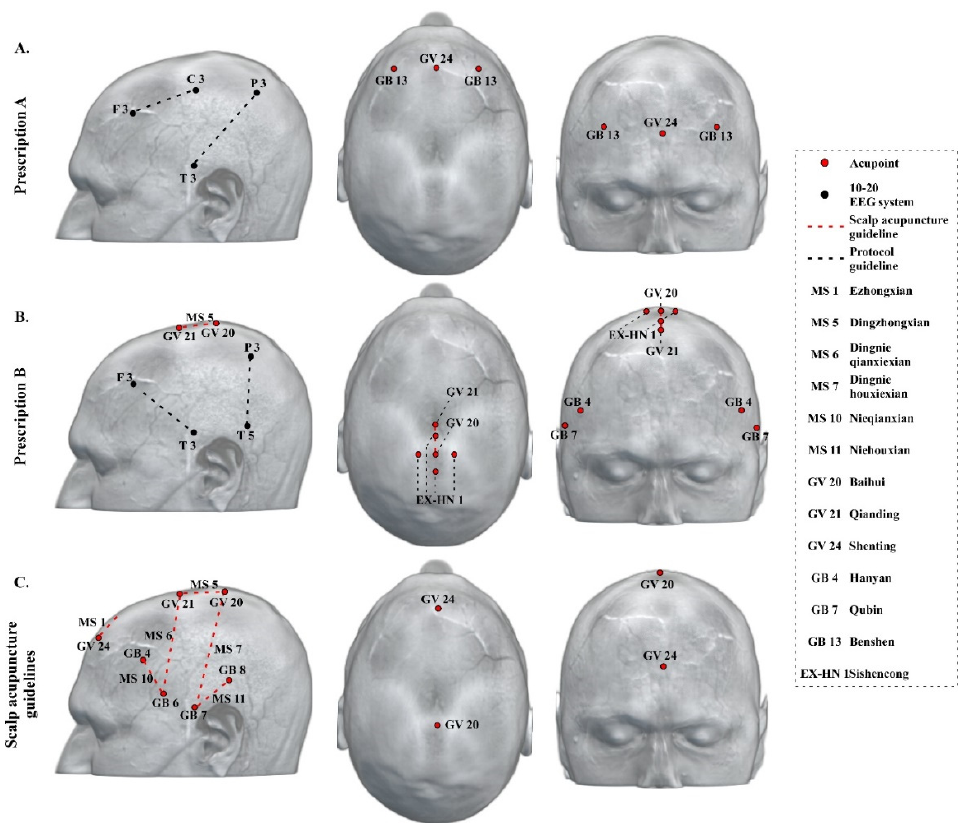
Figure 2. Neuroimaging-based scalp acupuncture prescription for dementia. ( A ) Prescription A, F3 to C3, T3 to P3, Shenting (GV 24), and bilateral Benshen (GB 13). B. Prescription ( B ) F3 to T3, P3 to T5, MS 5, Sishencong (EX-HN 1), bilateral Hanyan (GB 4), and Qubin (GB 7). ( C ) Textbook-documented scalp acupuncture guidelines. MS 1 (Ezhongxian, the middle line of forehead), 1 cun long from Shenting (GV 24) straight downward along the meridian; MS 5 (Dingzhongxian, the middle line of vertex), from Baihui (GV 20) to Qianding (GV 21) along the midline of head; MS 6 (Dingnieqianxiexian, the anterior oblique line of vertex-temporal), from Qianding (GV 21) obliquely to Xuanli (GB 6); MS 7 (Dingniehouxiexian, the posterior oblique line of vertex-temporal), from Baihui (GV 20) obliquely to Qubin (GB 7); MS 10 (Nieqianxian, anterior temporal line), from Hanyan (GB 4) to Xuanli (GB 6); and MS 11 (Niehouxian, posterior temporal line), from Shuaigu (GB 8) to Qubin (GB 7). Abbreviation: MS, microsystem and scalppoints; GV, Governor Vessel; GB, Gallbladder meridian. Table 1. Coordinates of dementia-associated surface regions identified from meta-analysis.